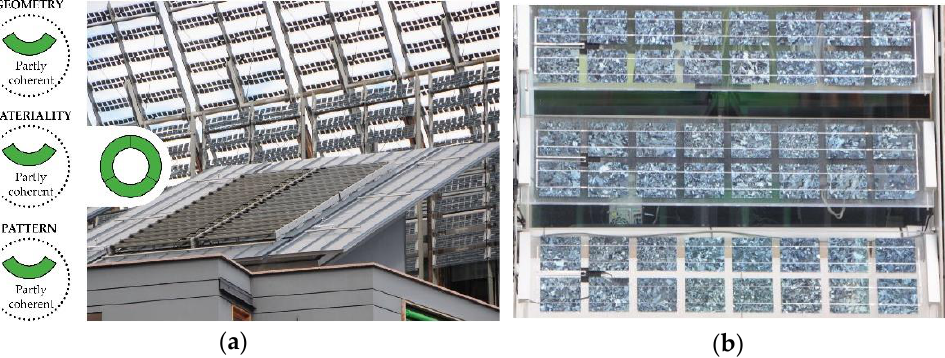
Figure 10. Architectural integration matrix for the PV systems in the Le Albere district in Trento (left); ( a ) the two typologies of BIPV systems: tedlar – glass modules on the galvanized roof and the glass – glass modules in the background (photo: © Silvia Croce); ( b ) detail of the glass – glass PV modules installed on the facades (photo: © Silvia Croce).